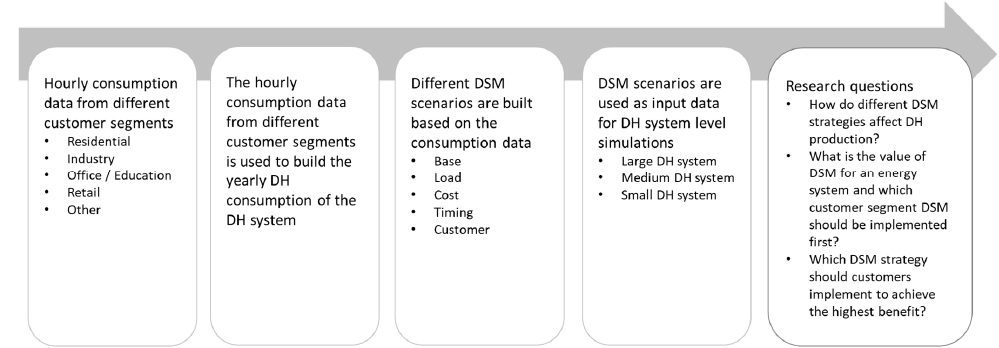
Figure 1. Methods, research questions and the course of the study.